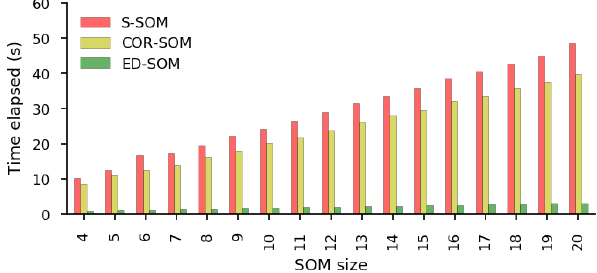
Figure 8. Computational time of S-SOM, COR-SOM, and ED- SOM. The x axis indicates the SOM size configurations; the y axis represents the elapsed time needed to complete the jobs. These are the results of the DJF experiments. Each experiment has with 3669 input samples; the size of each sample is 65 × 72 pixels. The num- ber of the SOM iteration steps is